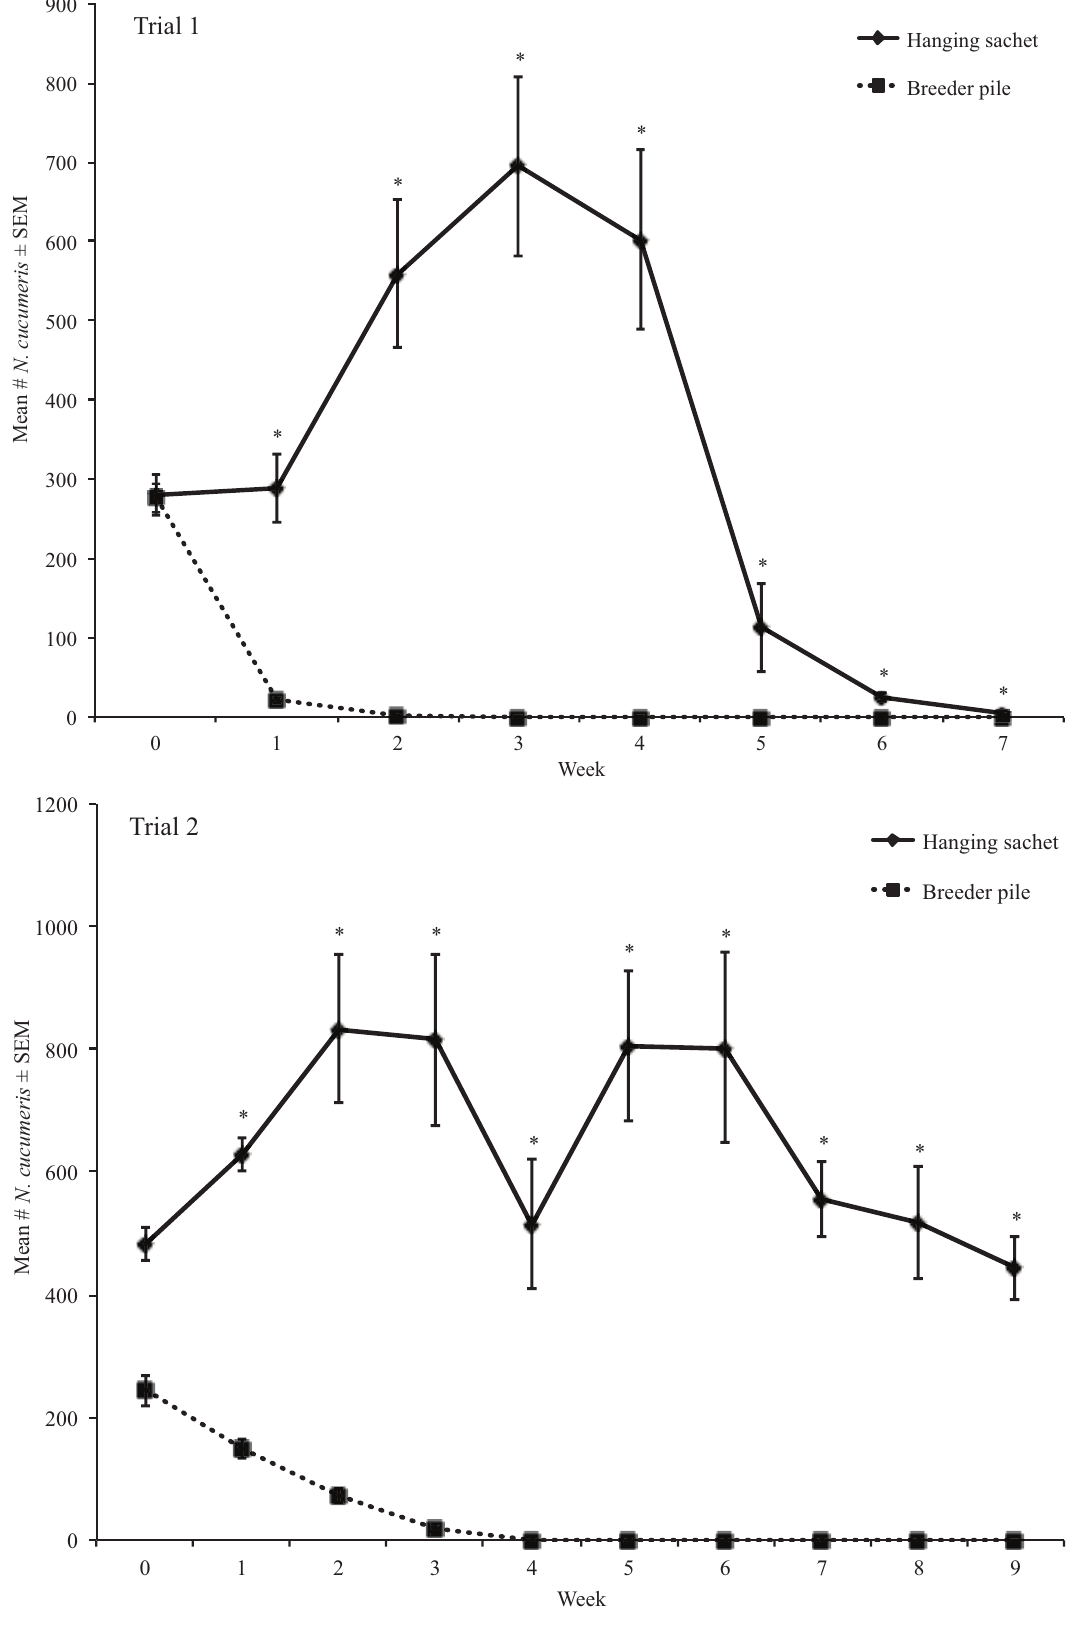
Figure 2. Mean number of N. cucumeris extracted from treatments in trials 1 and 2. * Means are significantly different among treatments in the same sampling period (Kruskal- Wallis, α =